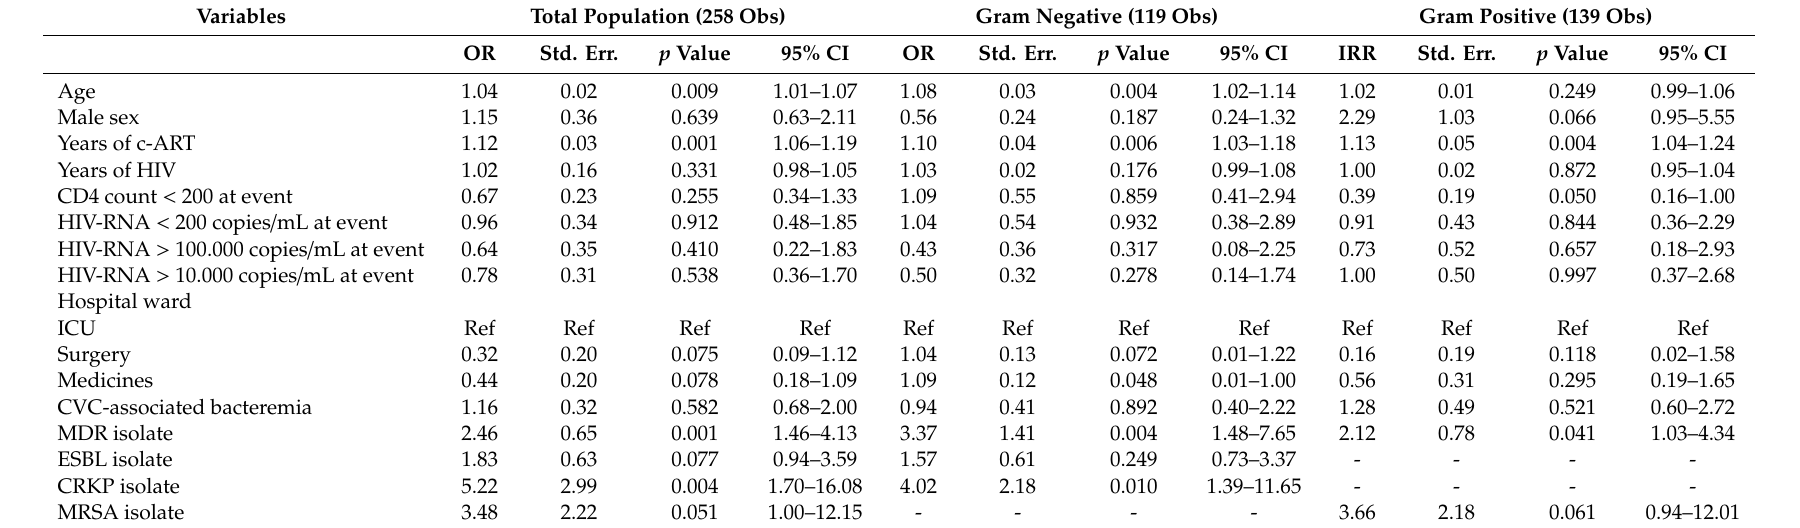
Table 2. Univariable GEE model for factors associated with